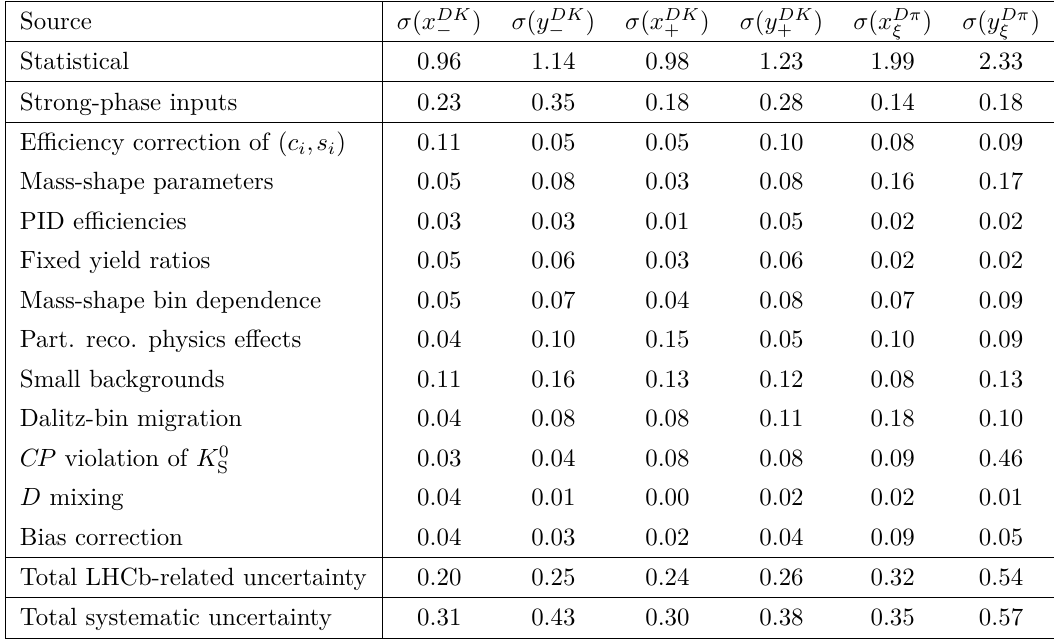
Table 2 . Overview of all sources of uncertainty, σ , on x DK are quoted × 10 − 2